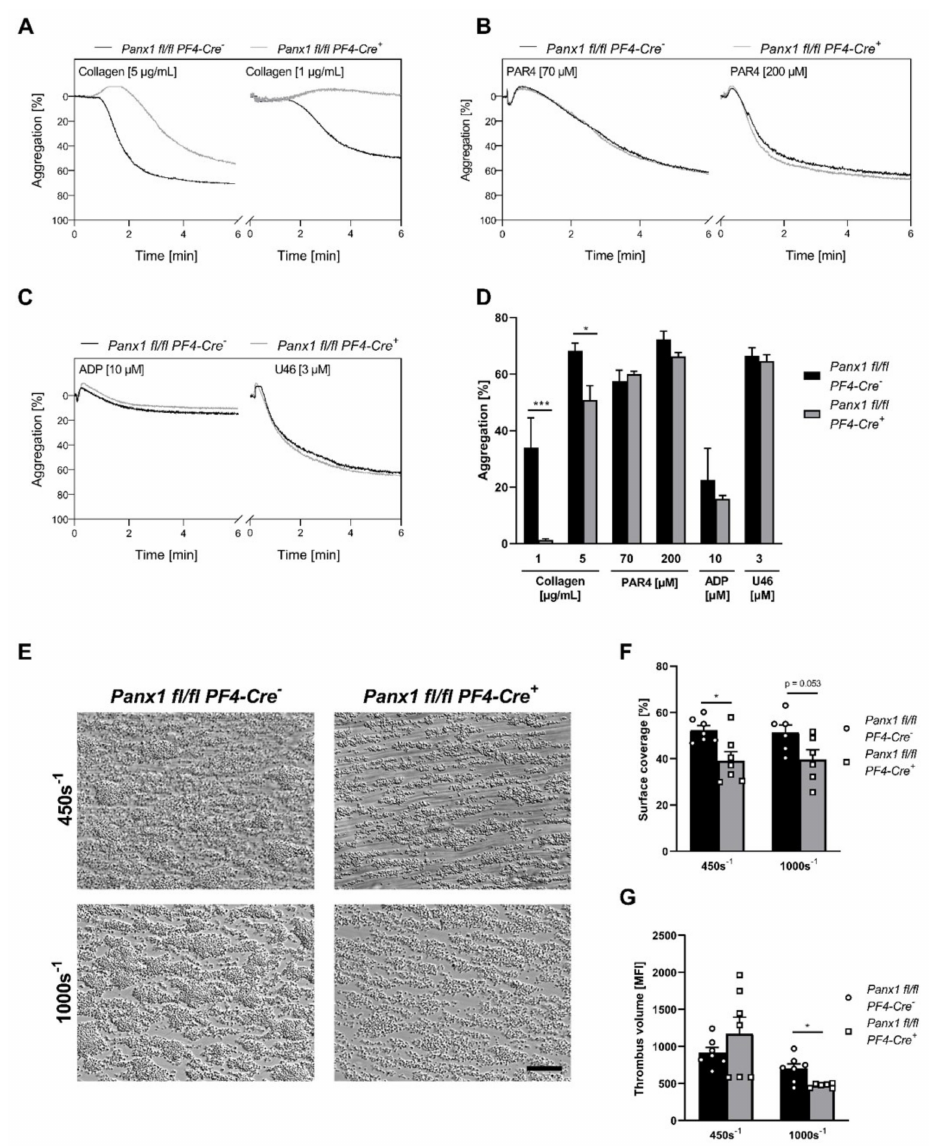
Figure 5. Reduced platelet aggregation and thrombus formation with whole blood from mice with genetic deletion of PANX1 in platelets: ( A – D ) Isolated platelets from Panx1 fl/fl PF4-Cre − (WT) and Panx1 fl/fl PF4-Cre + (KO) mice were stimulated with indicated agonists and platelet aggregation was measured in the presence of apyrase (0.04 U/mL) for 6 min using light transmission aggregometry. Representative curves of platelet aggregation where platelets were activated with ( A ) 5 and 1 µ g/mL collagen ( n = 4–9), ( B ) 70 and 200 µ M PAR4 peptide ( n = 6–10) and ( C ) 10 µ M ADP and 3 µ M U46619 ( n = 4–10). ( D ) The bar graph depicts mean values of platelet aggregation in responses to indicated agonists. ( E ) Representative images of thrombus formation under flow conditions using whole blood from Panx1 fl/fl Pf4-Cre + and Panx1 fl/fl Pf4-Cre − mice. Whole blood was perfused over a collagen-coated matrix at a shear rate of either 450s − 1 ( n = 7) or 1000s − 1 ( n = 6). The scale bar represents 100 µ M. ( F ) Analysis of surface coverage (%) and ( G ) thrombus volume (MFI) of three-dimensional thrombi. Statistical analyses were performed using ( D , G ) a two-way ANOVA followed by a Sidak’s multiple comparisons post-hoc test. Bar graphs indicate mean values ± SEM, * p < 0.05 and *** p < 0.001. Rest = resting, PAR4 peptide = protease- activated receptor 4 peptide, ADP = Adenosine diphosphate, U46619 (U46) = thromboxane analogue, WT = wild type, KO = knock-out, MFI = mean fluorescence